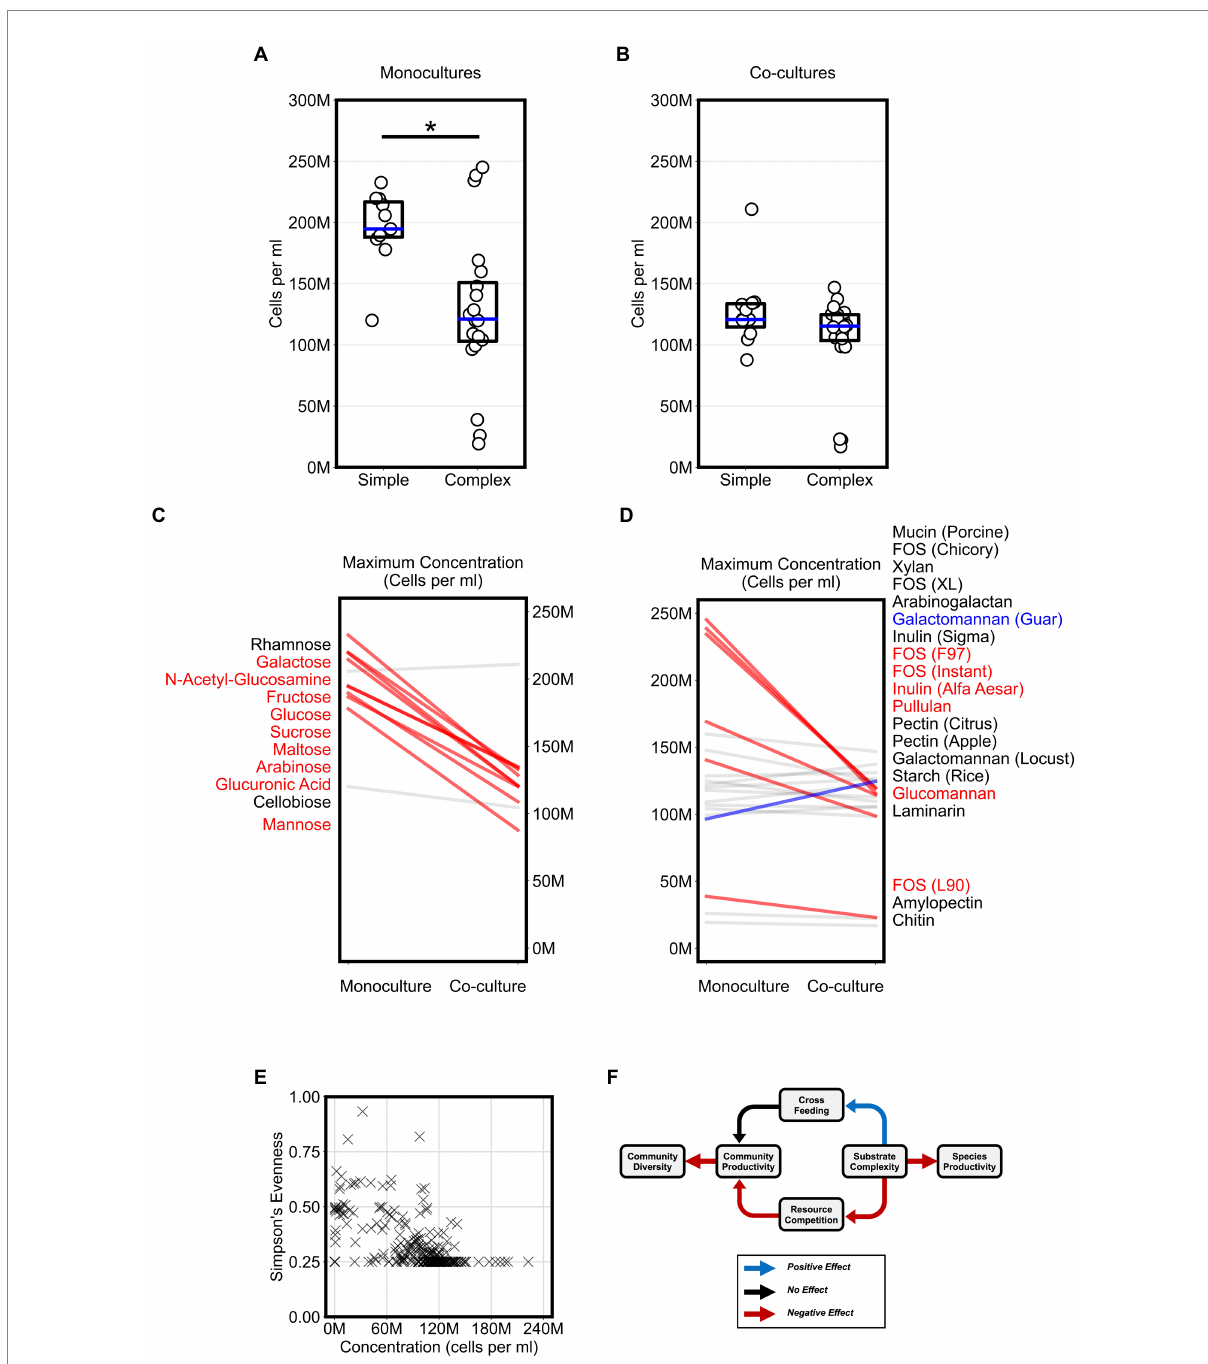
FIGURE 3 Competition for substrates lowers community productivity but increases diversity. (A,B) Plots display the “maximum monoculture productivity” and “maximum co-culture productivity” on each of the tested simple and complex substrates. Boxplots show the range between the first and third quartiles and blue lines indicate medians. Each data point is an average of two experimental replicates. Asterisks indicate an adjusted p -value < 0.05 for Bonferroni-corrected nonparametric Mann–Whitney U -tests. (C,D) Maximum productivity of monocultures and co-cultures separated by simple and complex sugars, respectively. Absolute abundances (cells per ml) in co-cultures that are at least 20% higher or lower than their corresponding abundances in monocultures are highlighted with thicker lines and colored either blue or red, respectively. Substrate annotations are ordered by abundance values in co-cultures. (E) Scatter plot of community evenness against absolute abundance for all co-culture samples in this study. (F) Schematic for a working model of the impact of substrate complexity on microbial interactions, productivity, and diversity. In all plots, “M” indicates values in the